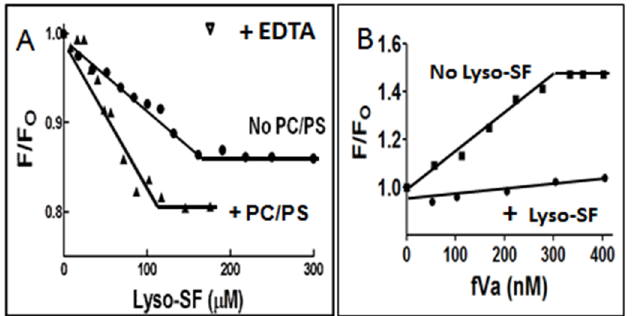
Fig 5. Fluorescence spectroscopy binding studies. (A) Binding of Lyso-SF to fXa in the presence or absence of PL Vesicles. The binding of fXa to lyso-SF was monitored by fluorescence spectroscopy. Samples containing DEGR-fXa i (initially 200 nM) in 50 mM Hepes (pH 7.4), 150 mM NaCl, 5 mM CaCl 2 either in the presence (closed triangles) or absence (closed circles) of PC/PS vesicles were titrated with lyso-SF and the net fluorescence intensity recorded. At the end of the titration, EDTA (10 mM) was added to reverse the fluorescence change. F was the fluorescence intensity at any given point in the titration and F o was the initial fluorescence intensity, before the addition of lyso-SF. (B) Binding of FVa to DEGR-fXa/PL in the presence or absence of Lyso-SF. DEGR-fXa i (initially 200 nM) in 50 mM Hepes (pH 7.4), 150 mM NaCl, 5 mM CaCl 2 was titrated with 25 μ M PC/PS vesicles prior to the addition of 100 μ M lyso-SF (closed circles) or buffer (closed squares). Subsequently the complex was titrated with fVa and the net fluorescence intensity of DEGR-fXa i recorded at λ ex = 340 nm and λ em = 530 nm, respectively. F was the fluorescence intensity at any given point in the titration and F o was the initial fluorescence intensity before the addition of